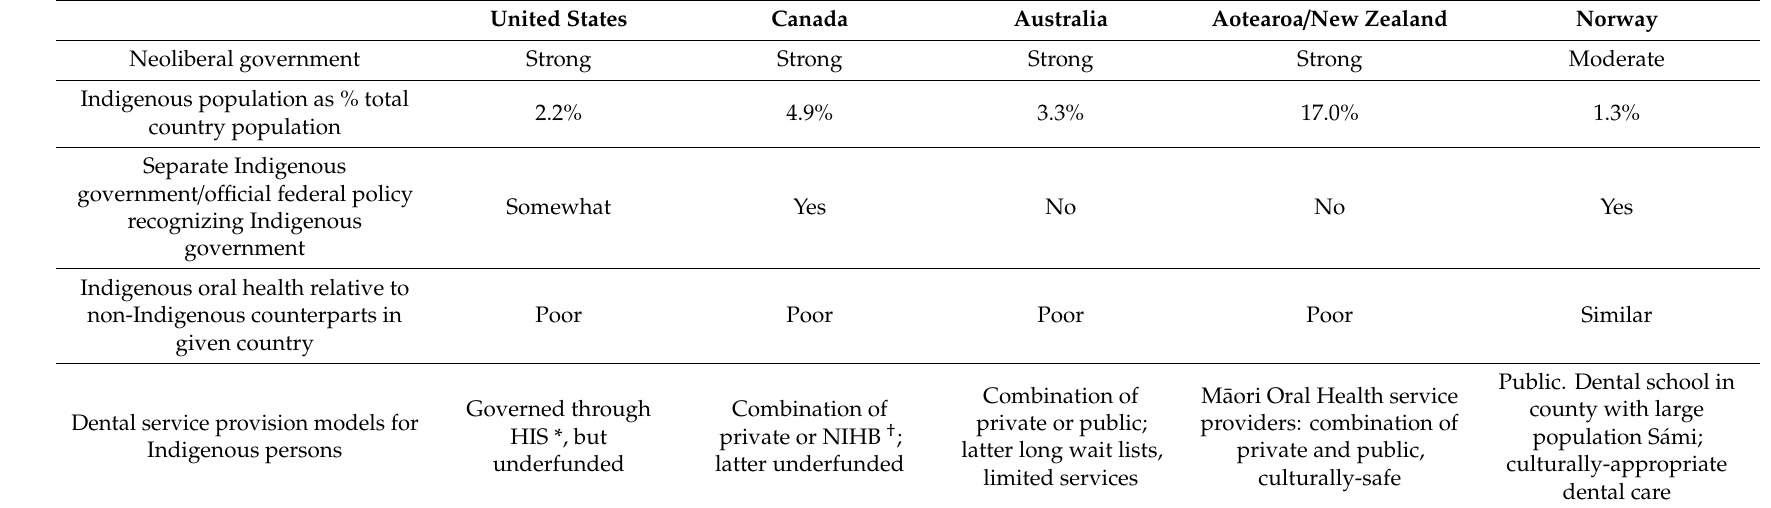
Table 1. Brief encapsulation of neoliberalism’s influence of Indigenous oral health in five